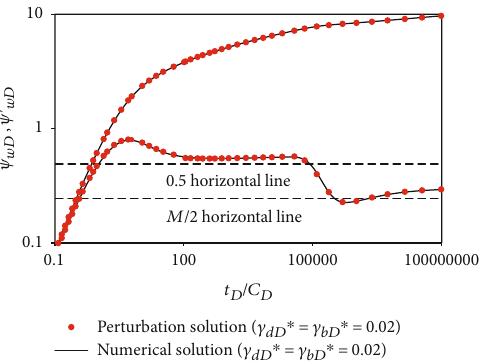
Figure 4: Comparison between the numerical solution and the perturbation solution to the pressure drawdown well test considering the stress sensitivity e ff